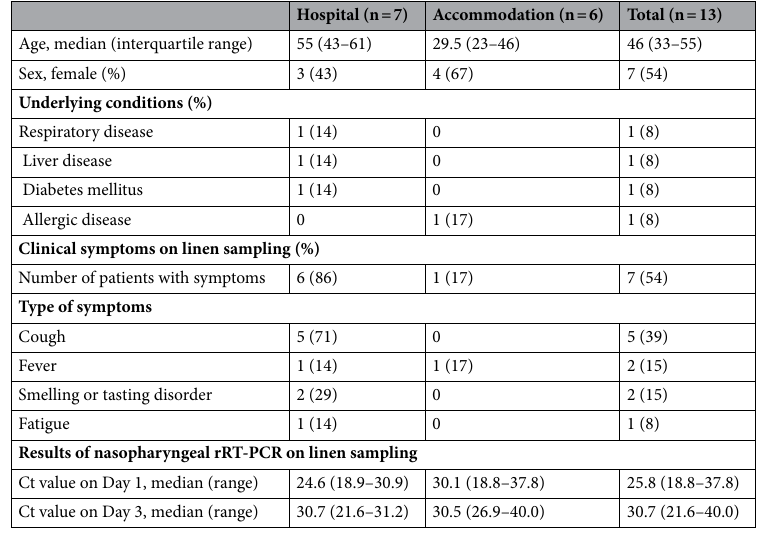
Table 1. Participant demographic characteristics and clinical